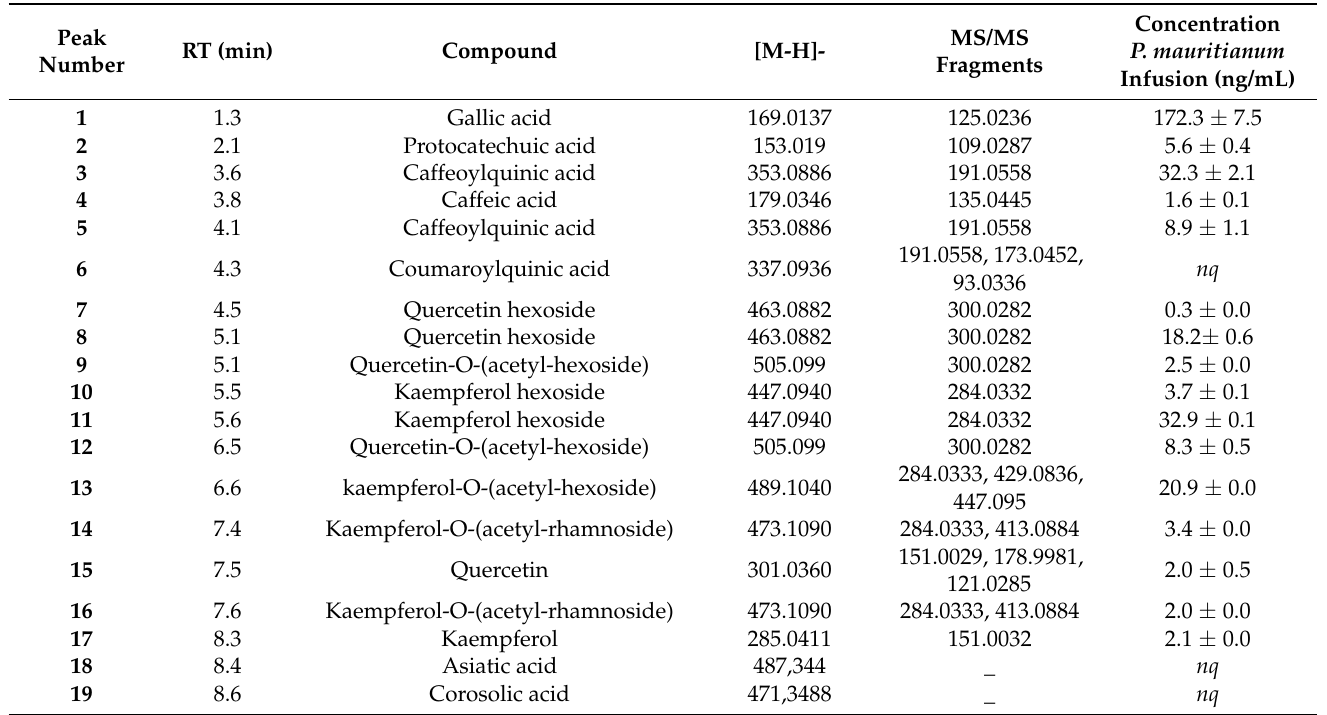
Table 2. Identification and quantification of compounds from aqueous extract of P. mauritianum (0.25 g/L) by LC-MS/MS analysis. Spectra analysis was also performed (upper spectrum: repre- sentative total ion chromatogram (TIC) obtained in negative mode; lower spectrum: HPLC-UV chromatogram obtained at 280 and 320 nm). Results are expressed as mean in ng/mL. RT, retention time. Nq, not quantified. Note that numbers correspond to the ones shown on the different spectra from Figure 1 (peak numbers reported in the table). Note that some isomers were detected (e.g., kaempferol